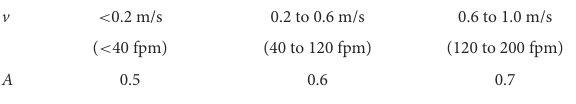
TABLE 3 Values of A that vary with v